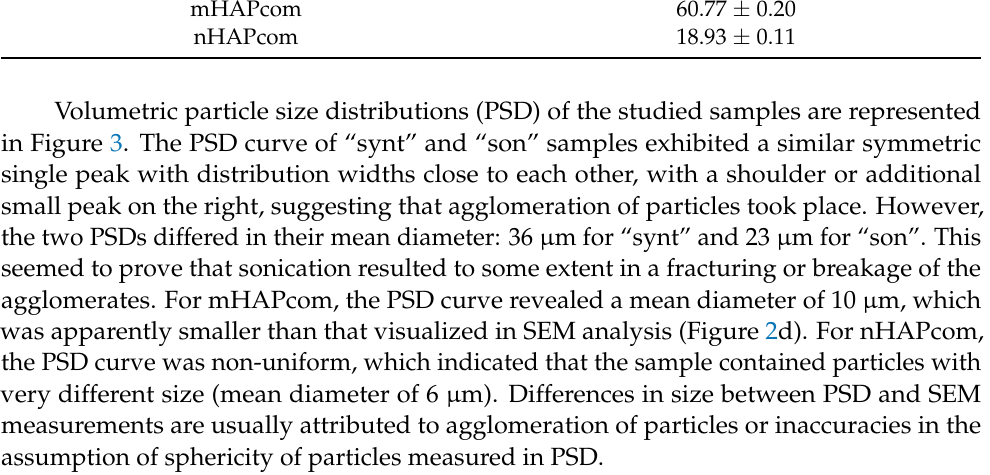
Table 1. Measured values of S BET surface areas for all studied sorbents.